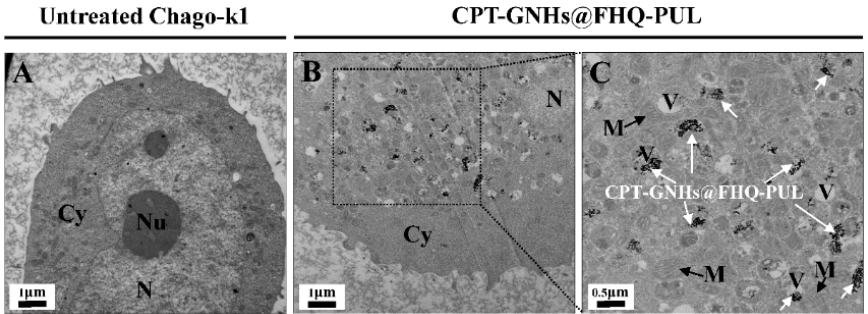
Figure 6. TEM images of Chago-k1 cells after culturing ( A ) without or ( B , C ) with CPT-GNHs@FHQ- PUL at 37 °C for 72 h (Nu = nucleolus, N = nucleus, V = vacuole, M = mitochondria and Cy = cyto- plasm).